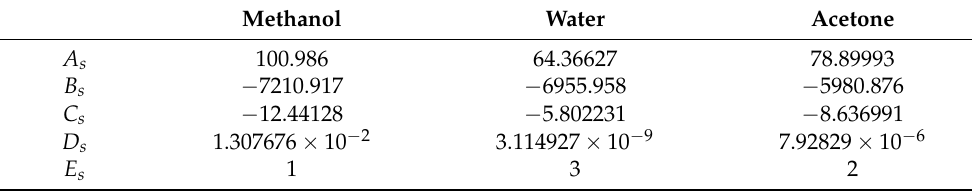
Table A1. Substance parameters for the